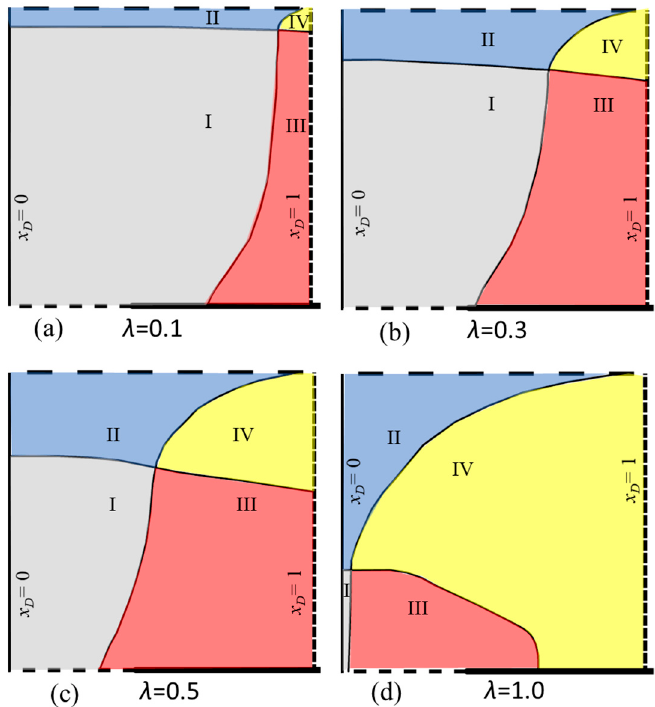
Figure 8. Change in well-location zones with different values of λ when the other parameters are specified as α = 0.4, β = 1 and γ = 1: ( a ) λ = 0.1; ( b ); λ = 0.3; ( c ): λ = 0.5; ( d ): λ = 1.0.